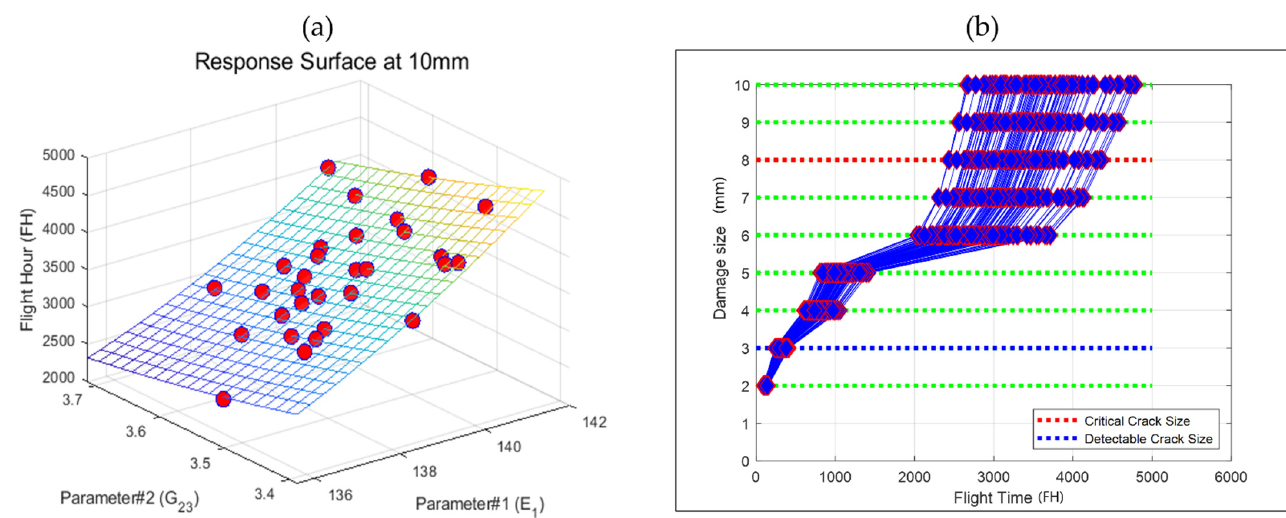
Figure 13. ( a ) Response surface generation using Latin hypercube sampling design and ( b ) the simulation response surface based on FEA simulations.